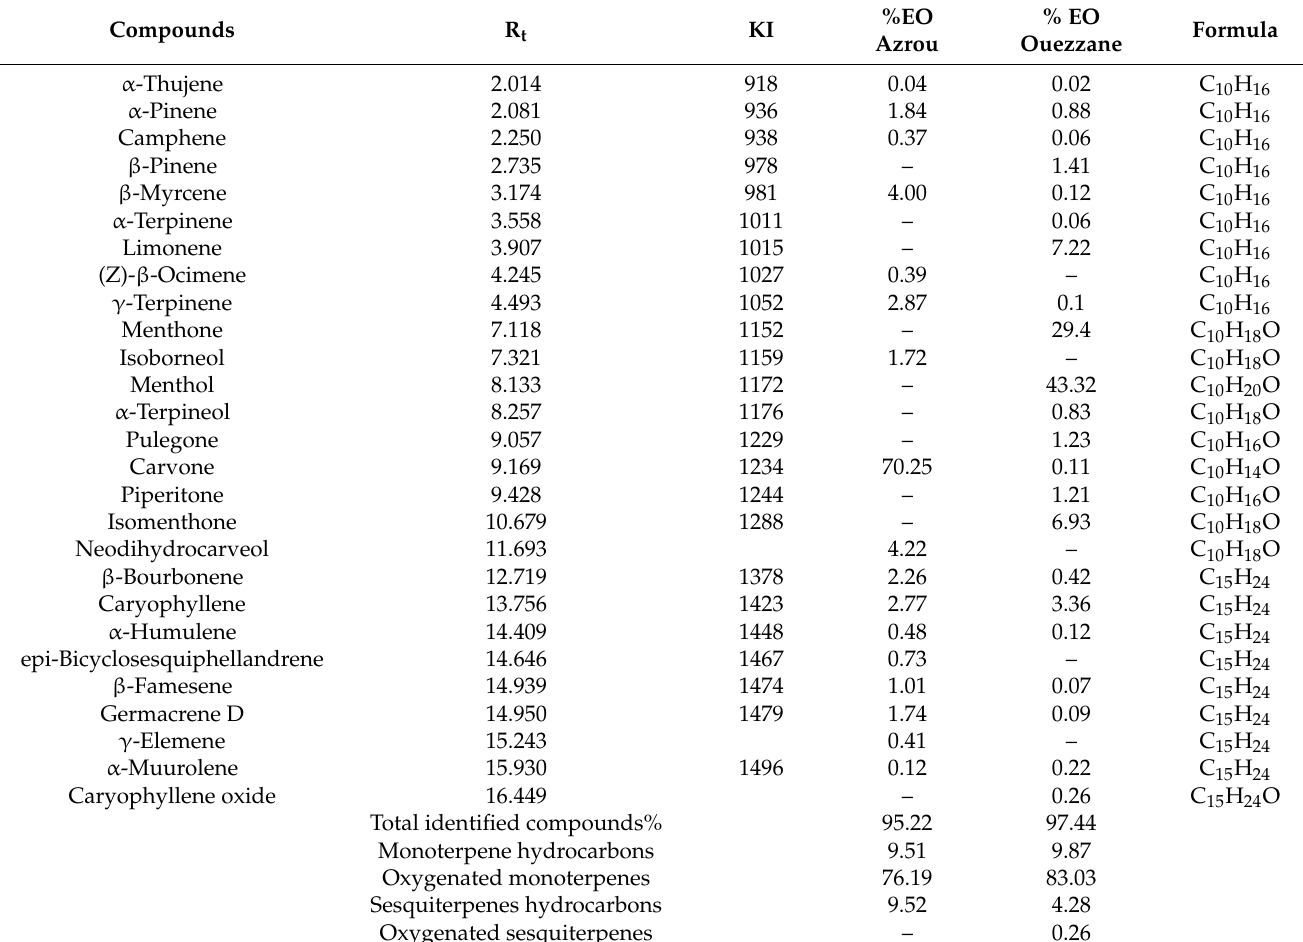
Table 1. Chemical composition of M. pepirita